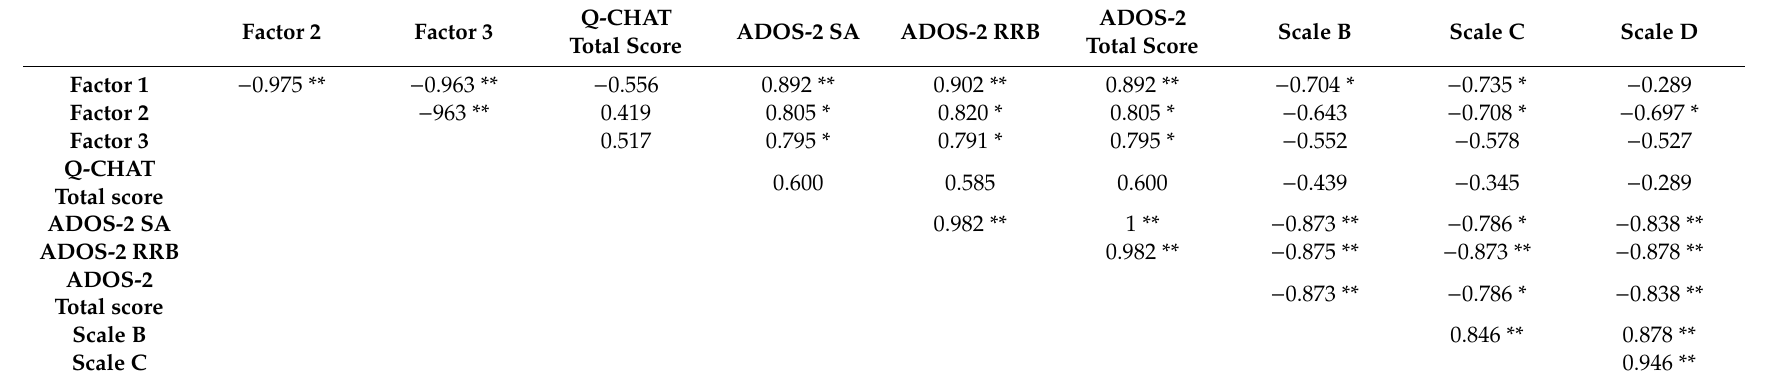
Table 8. Nonparametric correlation between the Q-CHAT factors and gold